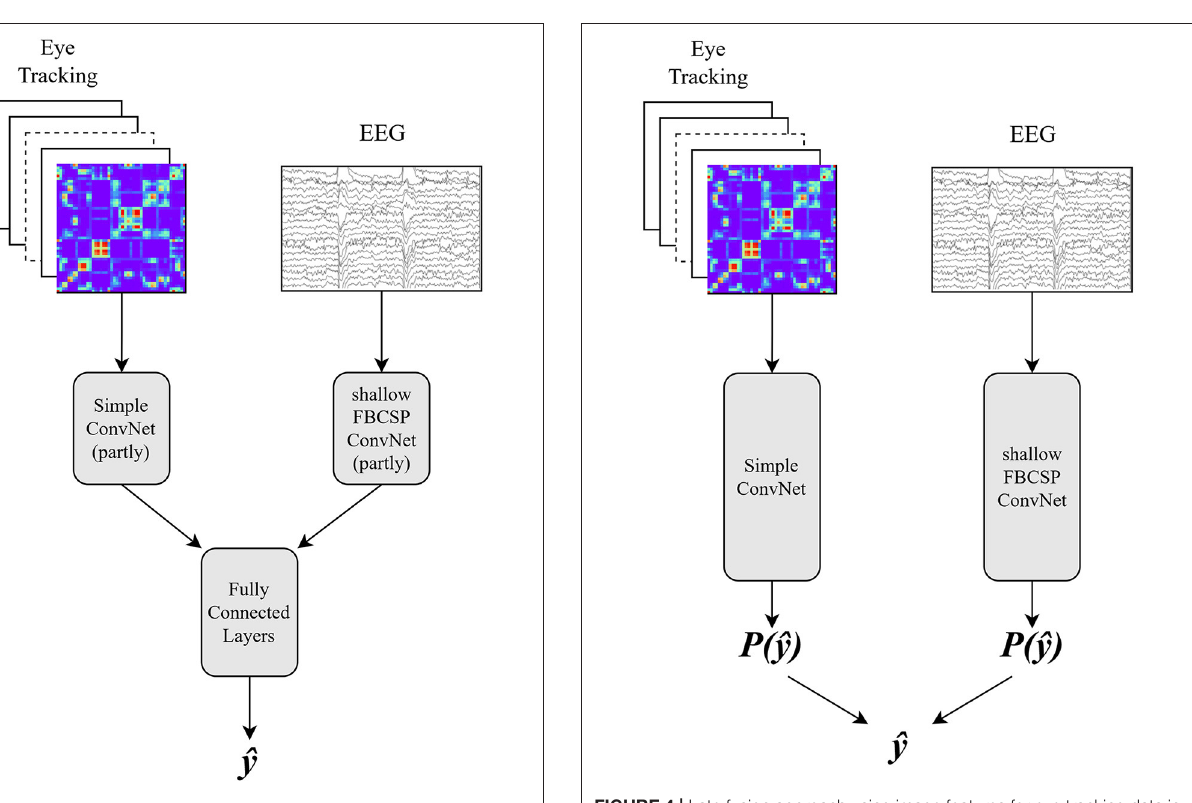
FIGURE 3 | Middle fusion approach using image features for eye tracking data in combination with the first steps of a Simple Convolutional Neural Network and the time series of EEG data with the reduced shallow FBCSP Convolutional Neural Network. The concatenated outputs are put through further linear layers. ˆ y is the class prediction.